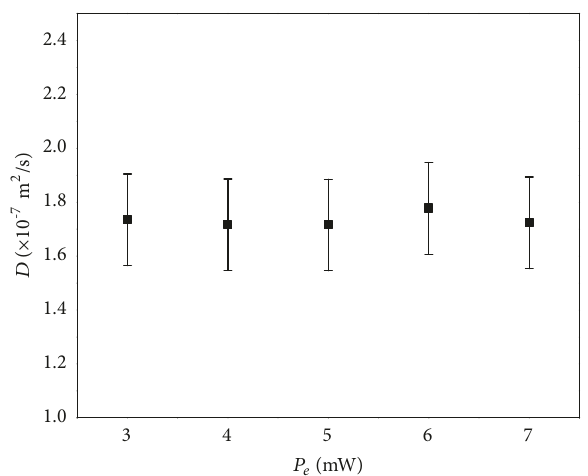
Figure 9: Thermaldiffusivity as afunctionof the powerof thepump beam for sample corresponding to 𝑓 = 1/3 .